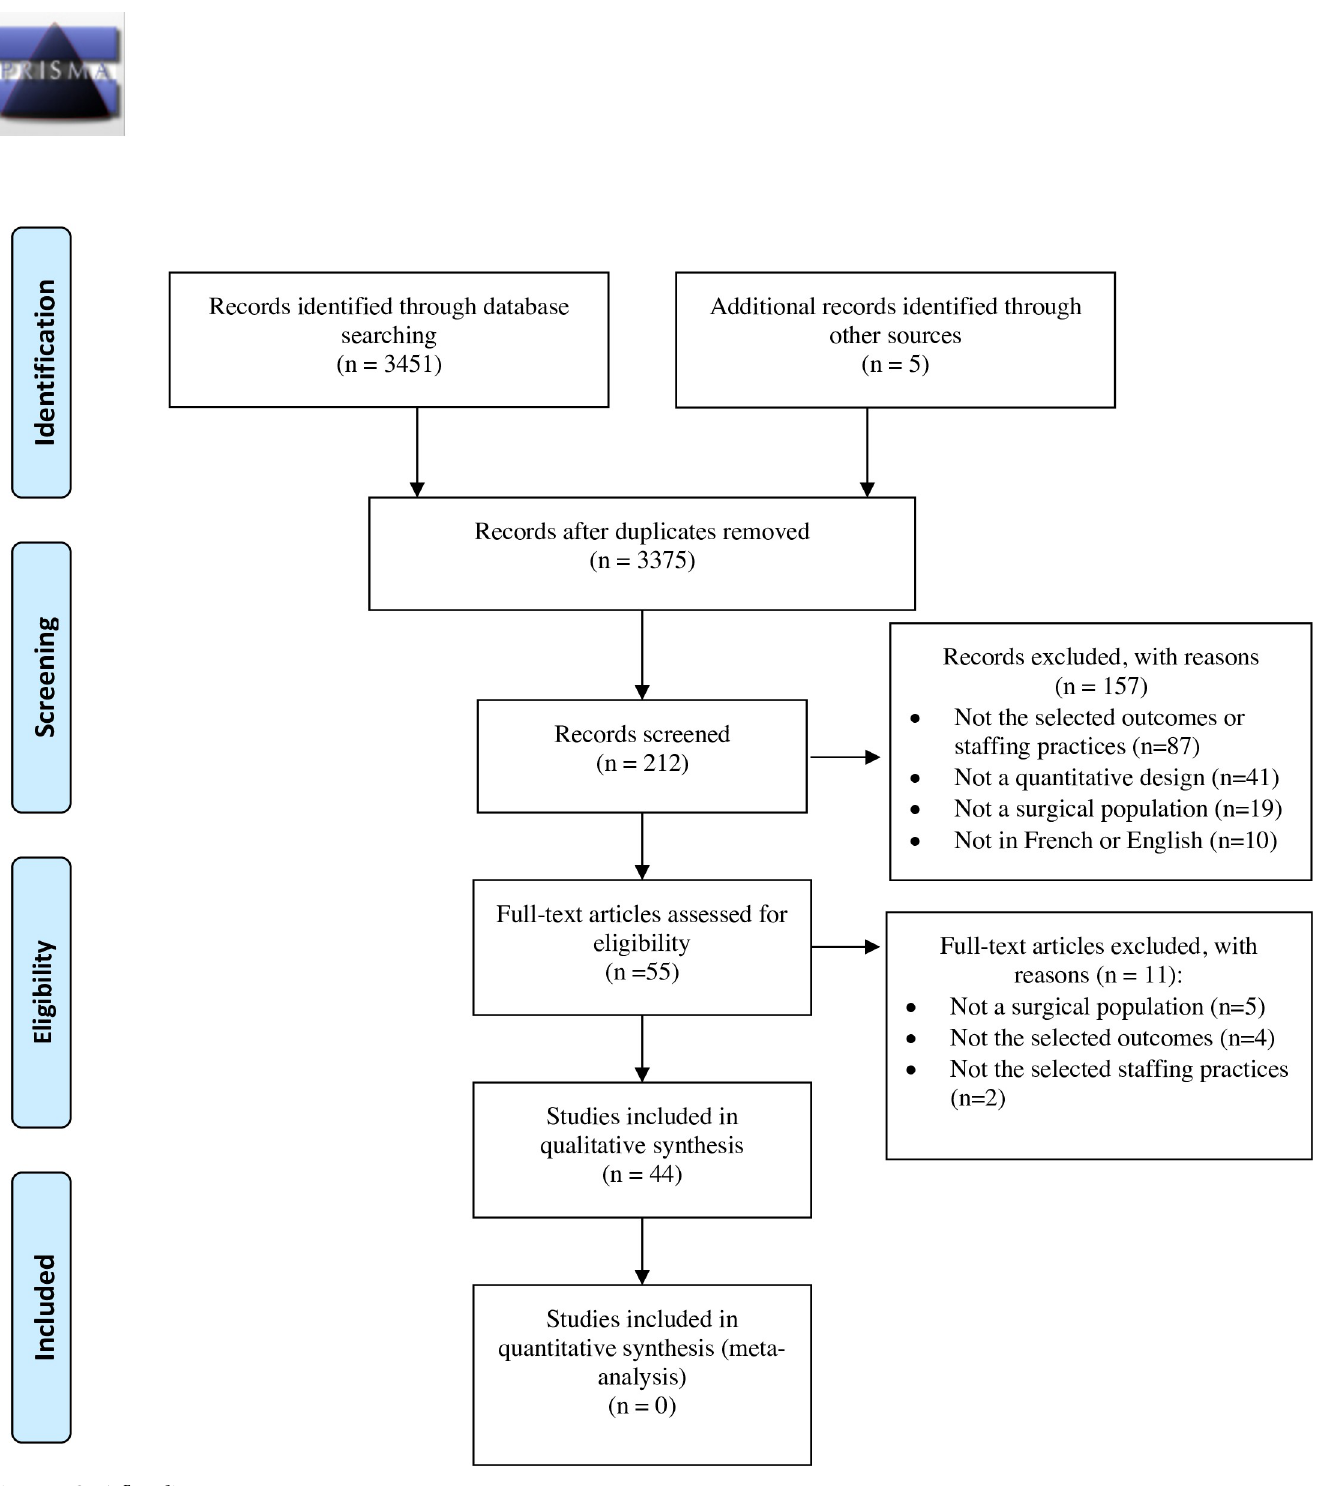
Fig 1. PRISMA flow diagram.